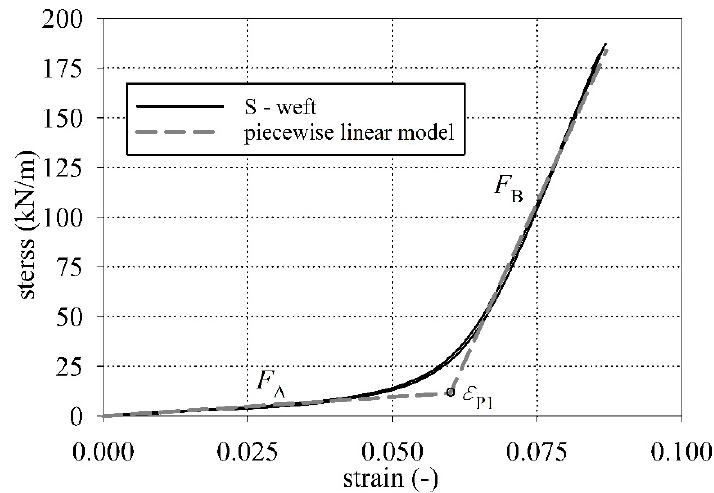
Figure 7. Graphical concept of the piecewise linear model identification.